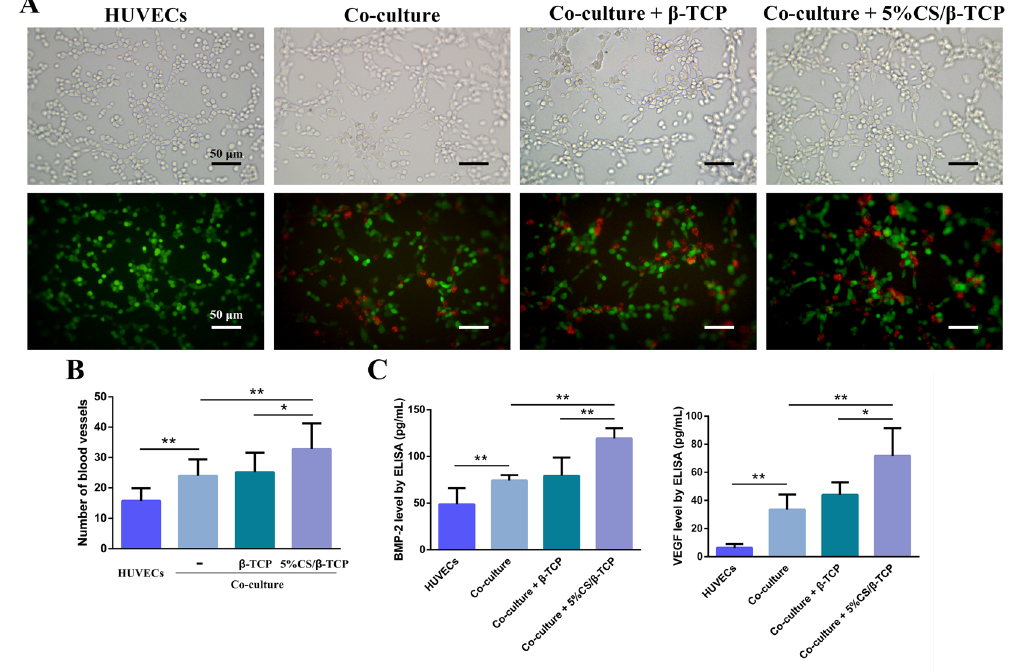
Figure 4. 5%CS/ β -TCP scaffolds enhanced angiogenesis in co-cultured HUVECs and hBMSCs. ( A ) Light microscopy (top) of tube formation on Matrigel, and fluorescence microscopy (bottom) of GFP-labelled HUVECs (green) stimulated for 4 h with β -TCP scaffolds or 5%CS/ β -TCP scaffolds in transwell inserts, in the presence or absence of hBMSCs labelled with CM-Dil (red). ( B ) Co-culture of HUVECs with hBMSCs stimulated tube formation relative to monocultured HUVECs. 5%CS/ β -TCP scaffolds further enhanced tube formation in co-cultured cells in comparison to pure β -TCP. ( C ) BMP-2 and VEGF secretion, as measured by ELISA. * p < 0.05; ** p < 0.01. Scale bar represents 50 μ